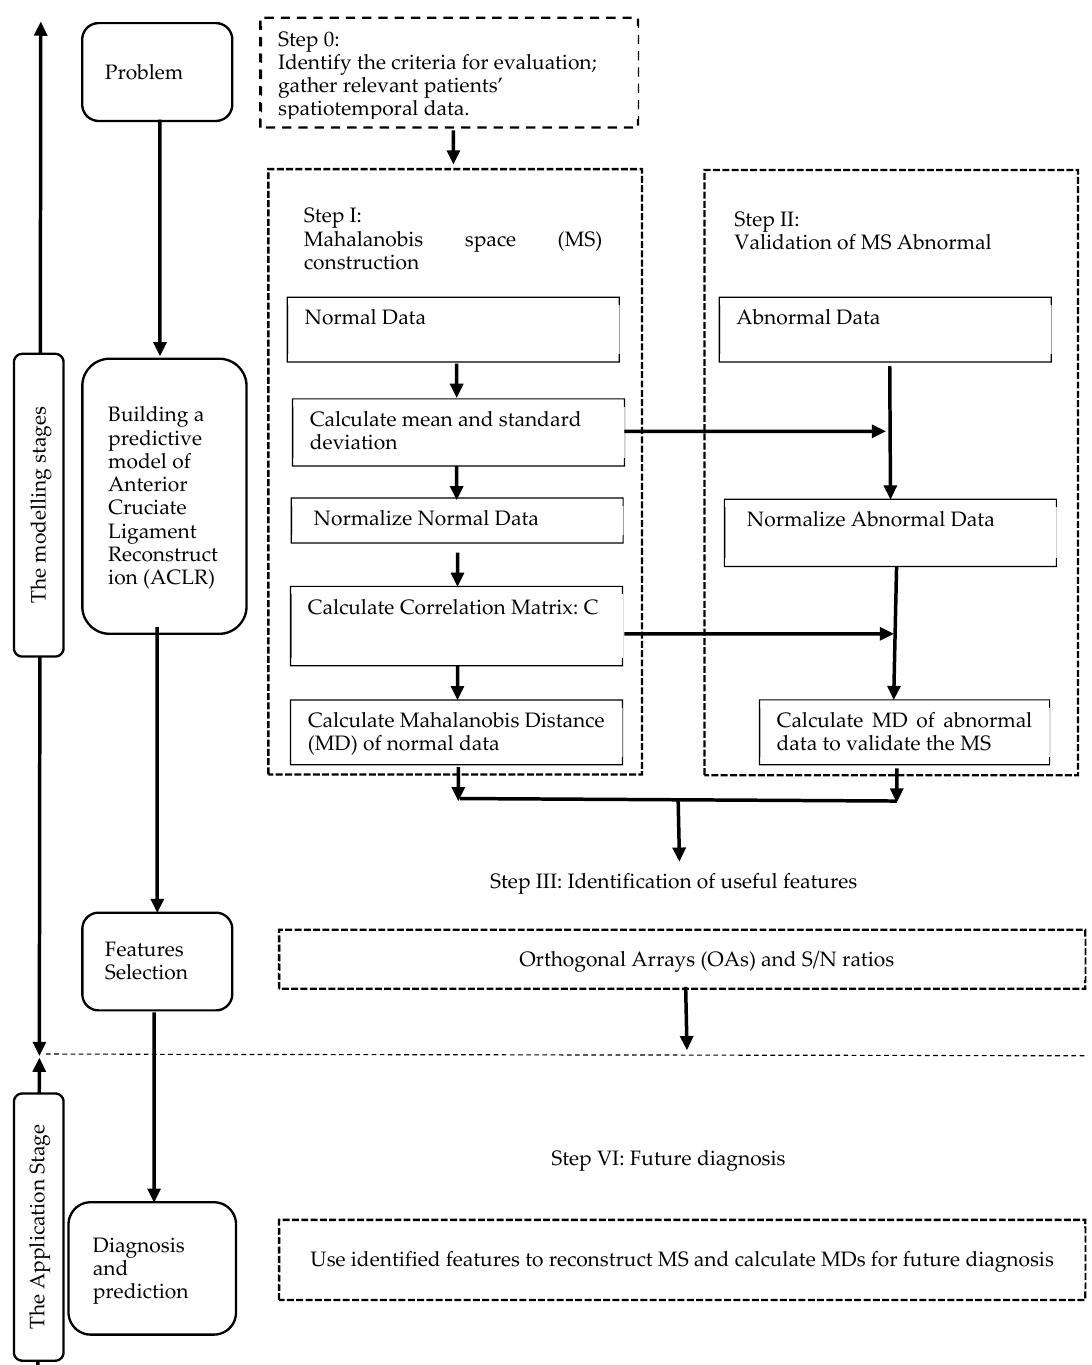
Figure 1. Flow chart of the approach proposed in this study.